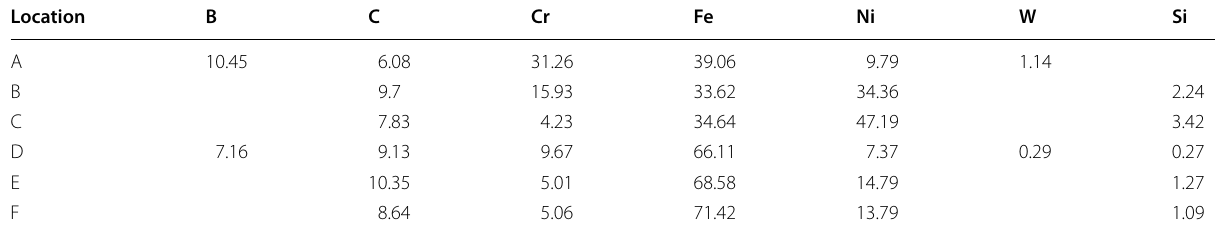
14 mesh and Nickel-based composite coating +